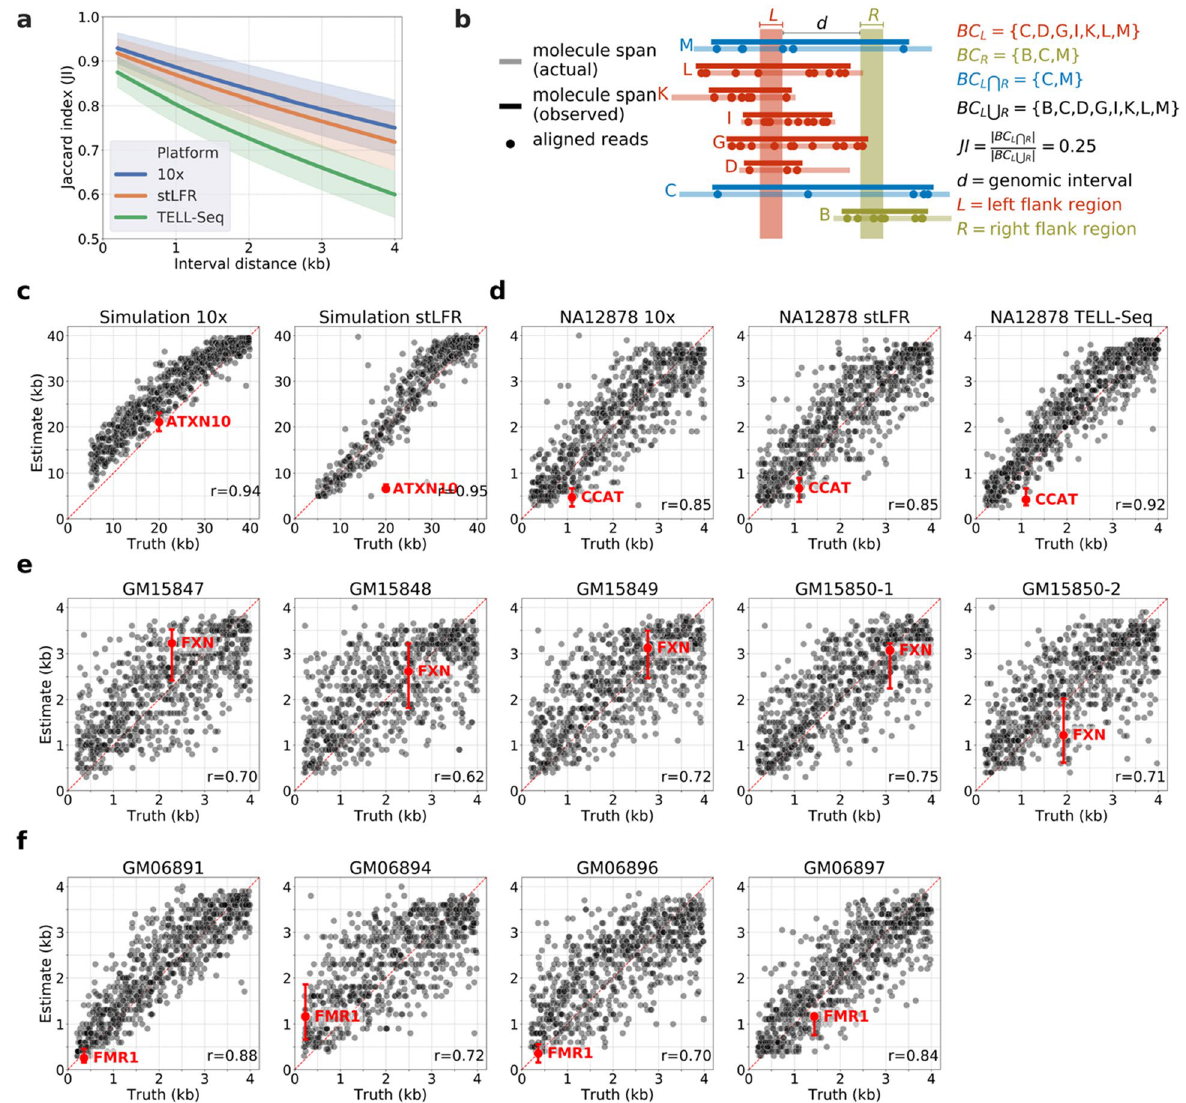
Figure 2. Size estimation of genomic intervals and STR loci using Jaccard index of barcode sharing in BLRS. ( a ) Inverse relationship between Jaccard index and genomic interval size observed in NA12878 of each of the three BLRS platforms. The colored bands correspond to the 95% confidence intervals for each platform. ( b ) Schematic of a hypothetical example illustrating the concept and terminology in computing the Jaccard index of barcode sharing for a given genomic interval. ( c – e ) Scatter plots of estimates ( y -axis) vs. truths ( x -axis) for ~ 700 arbitrary genomic intervals (black) and the target STR (red) in the simulation ( c ), NA12878 ( d ), FXN ( e ), and FMR1 ( f ) datasets. Only estimates of the expanded allele at the target loci were shown. Confidence intervals of the estimates of the target loci were shown as red error bars. Dotted red diagonal lines were added to help visualize the amount of deviation of the estimates from the true values. “Truths” ( x -axis) for the ~ 700 genomic intervals in all plots were calculated based on hg38 genomic coordinates. “Truth” for the target locus is the size of the ATXN10 repeat we replaced the reference with in the modified genome to generate the simulated datasets ( c ); size of the CCAT allele we determined from the NA12878 assembly ( d ); sizes of the FXN ( e ) and FMR1 ( f ) repeats in the Coriell samples according to on-line information of the respective cell lines (Table